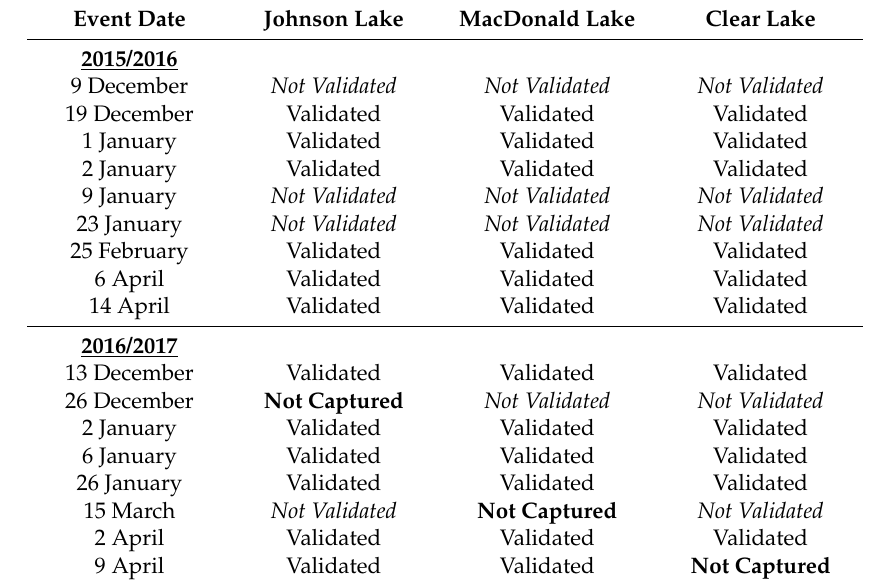
Table 2. Summary of the validation of major freeze events for the 2015/2016 and 2016/2017 ice seasons. “Validated” events were freeze events confirmed by shoreline observations and climate data. “Not Validated” events were identified as freeze by the threshold method but did not match observations in shoreline cameras or local climate data. “Not Captured” events indicate that no freeze event was reported for that lake on the specific date. Johnson Lake MacDonald Lake Clear